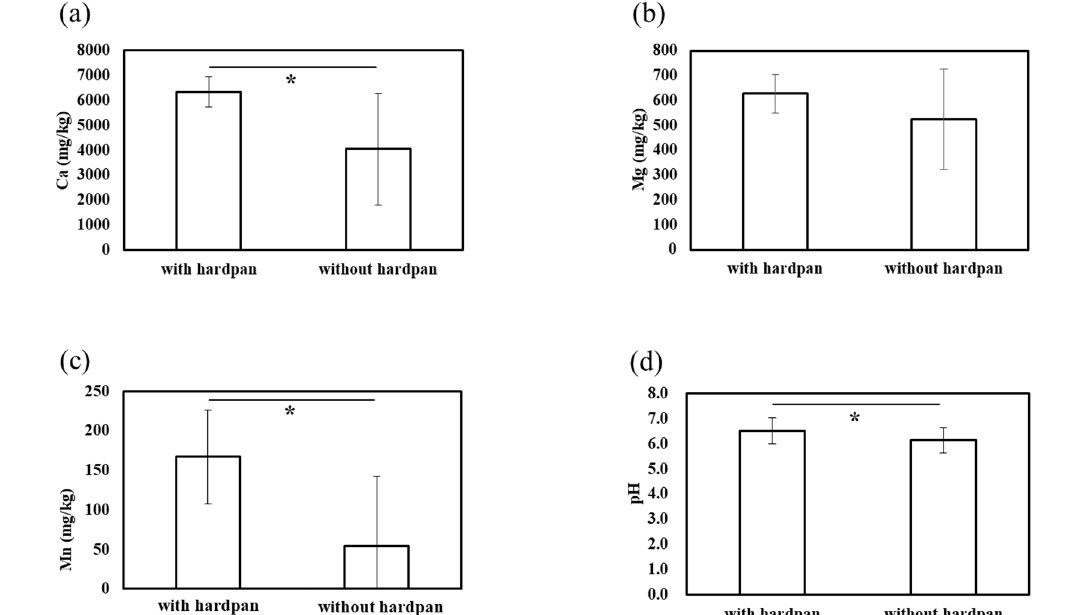
Figure 7. Mineral contents and pH in two groups categorized by hardpan formation. ( a ) Calcium, ( b ) magnesium, ( c ) manganese, and ( d ) pH. (*: Mann–Whitney U test, p <